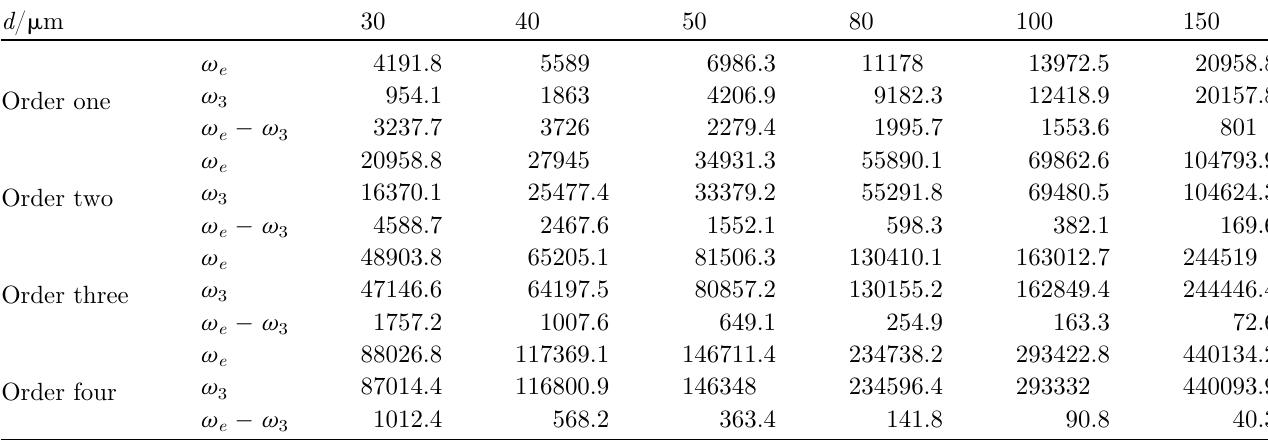
Table 4. Changes of natural frequency with d